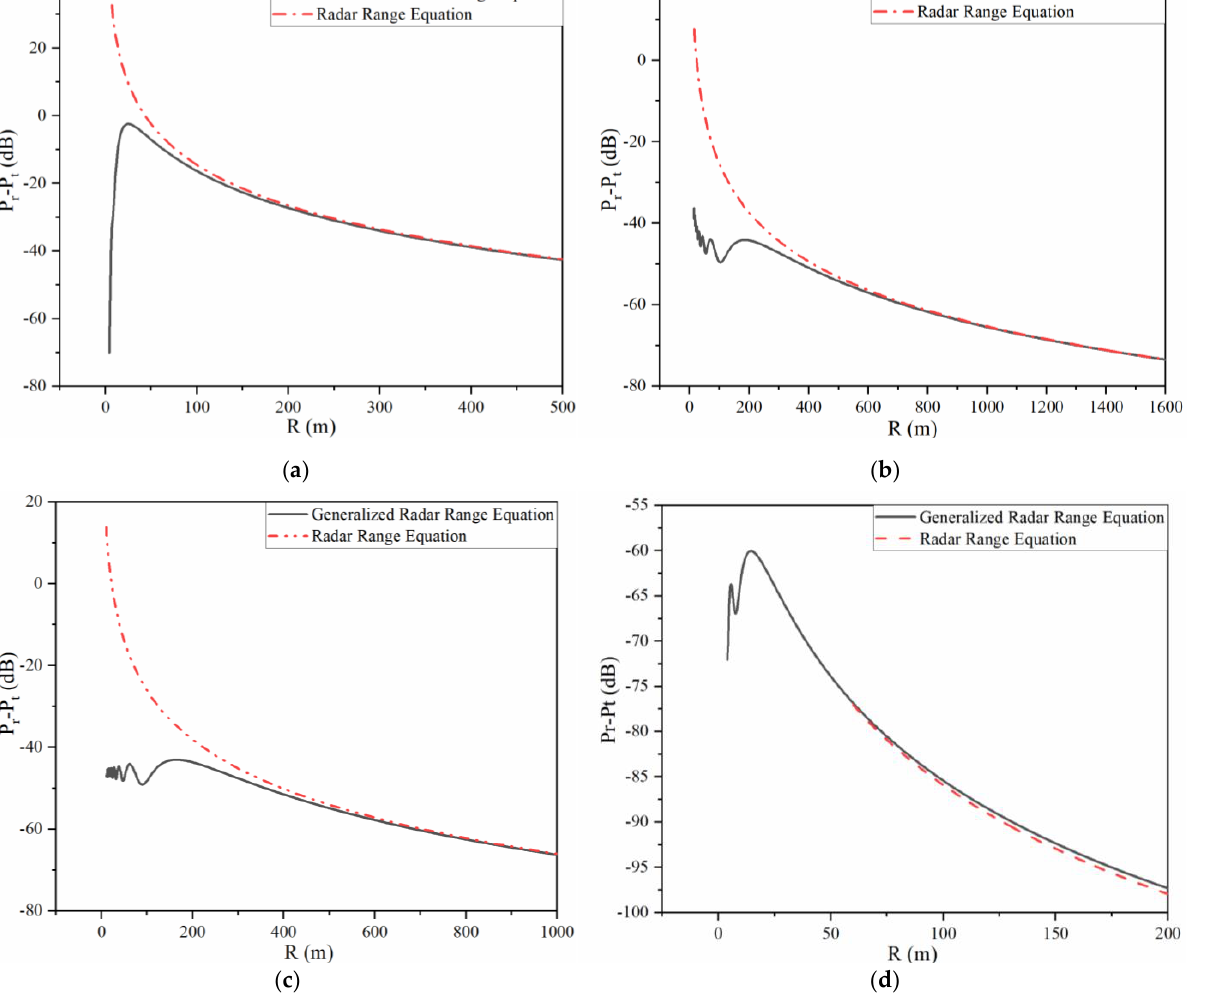
Figure 4. Relationship between () d B PP − and R in the whole range. ( a ) Plate, ( b ) sphere, ( c ) cyl- r t inder, ( d ) conical frustum. ( c ) cylinder, ( d ) conical